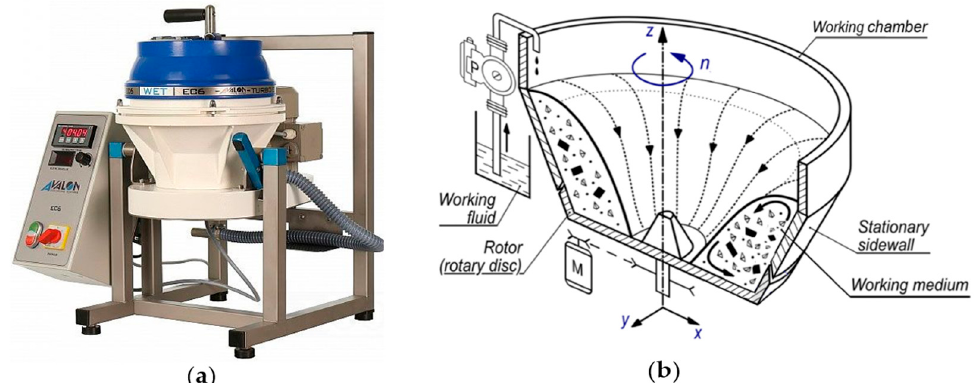
Figure 1. View of the EC6 smoothing machine ( a ) and a schematic diagram of its working chamber ( b ).